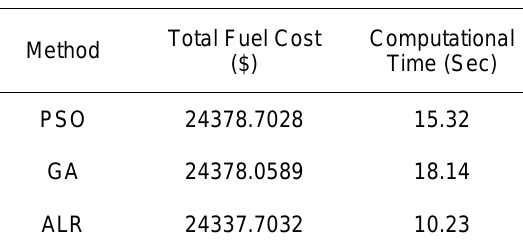
Algorithm for Scheduling a Large Pumped Storage